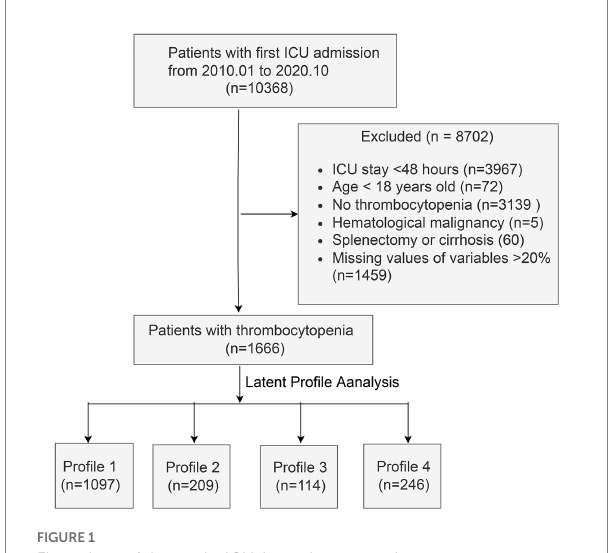
FIGURE 1 Flow chart of the study. ICU, intensive care unit.